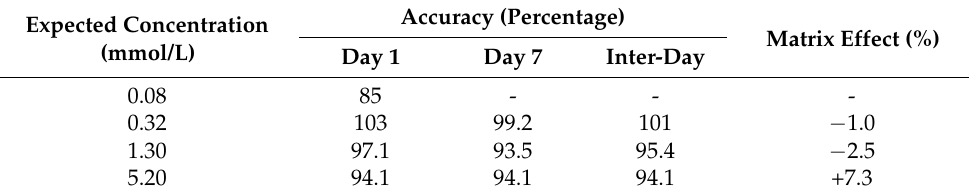
Table 2. Accuracy ( n = 10) and matrix effect ( n = 5) data of citrate-fortified synthetic urines.